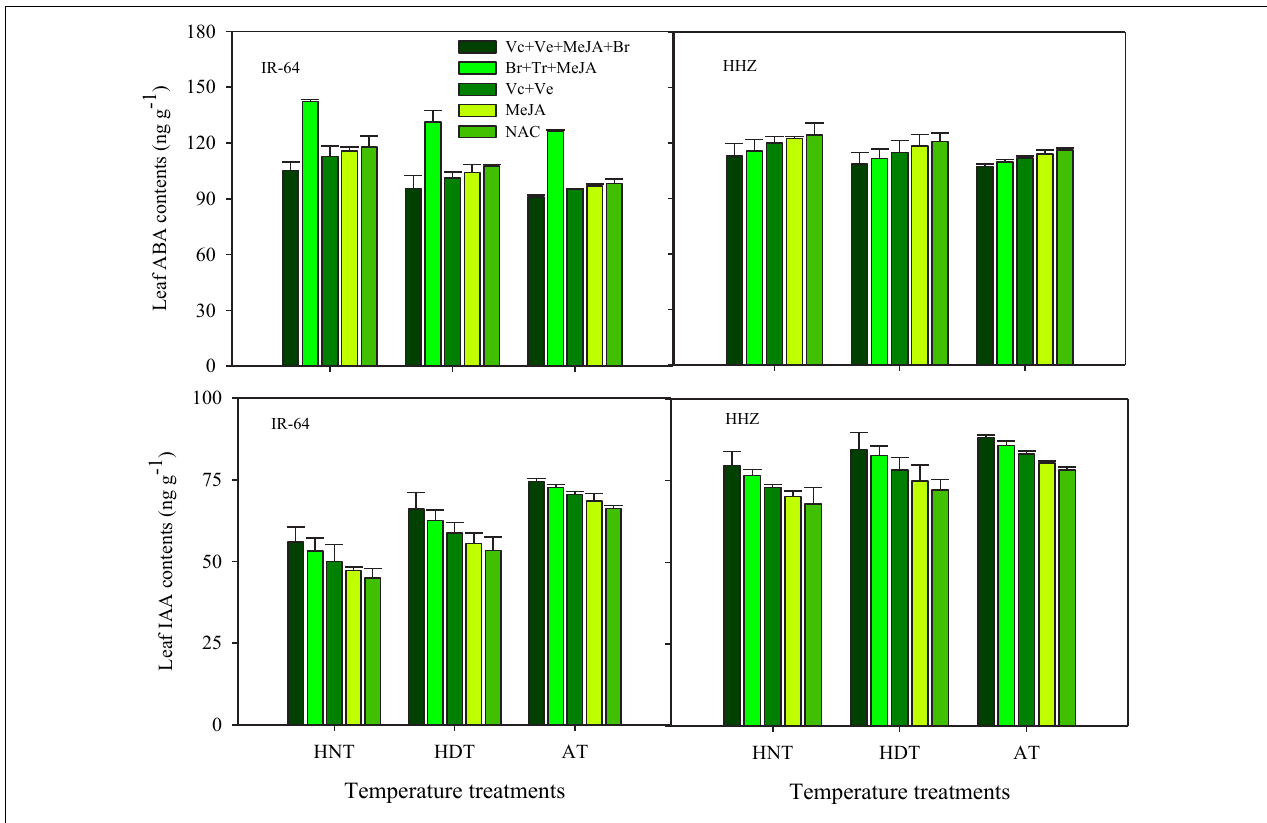
FIGURE 7 | Impact of PGRs on the concentration of abscisic acid (ABA) and indole-acetic acid (IAA) in rice leaves.